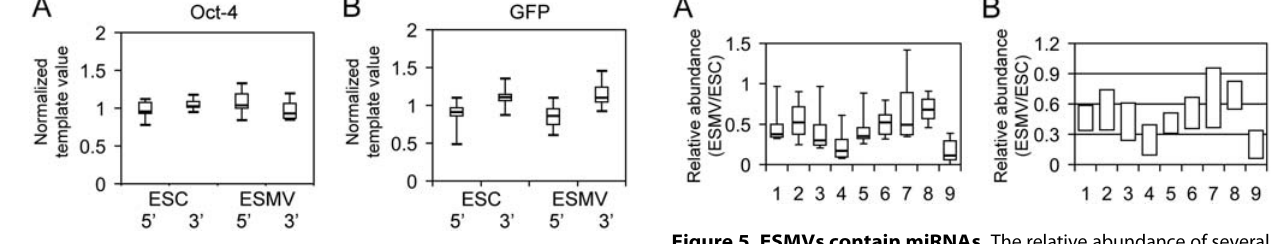
(Figure 6A). The same cells were then imaged using the corresponding filter to visualize GFP labeling (Figure 6B). Multiple green vesicles can be seen docked on the ESCs (arrows) and several patches of diffuse GFP signal can also be seen inside the cells near the plasma membrane and in the cytoplasm (arrowheads,